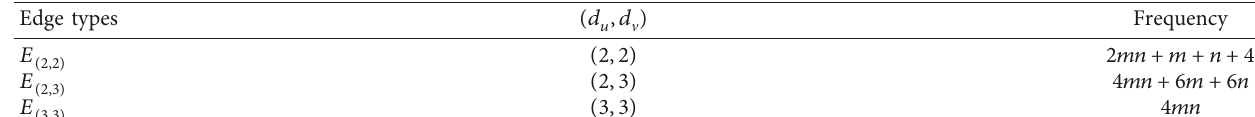
Ǥ 2 3 × 3 . Ǥ m n Nano sheet. 2 ×